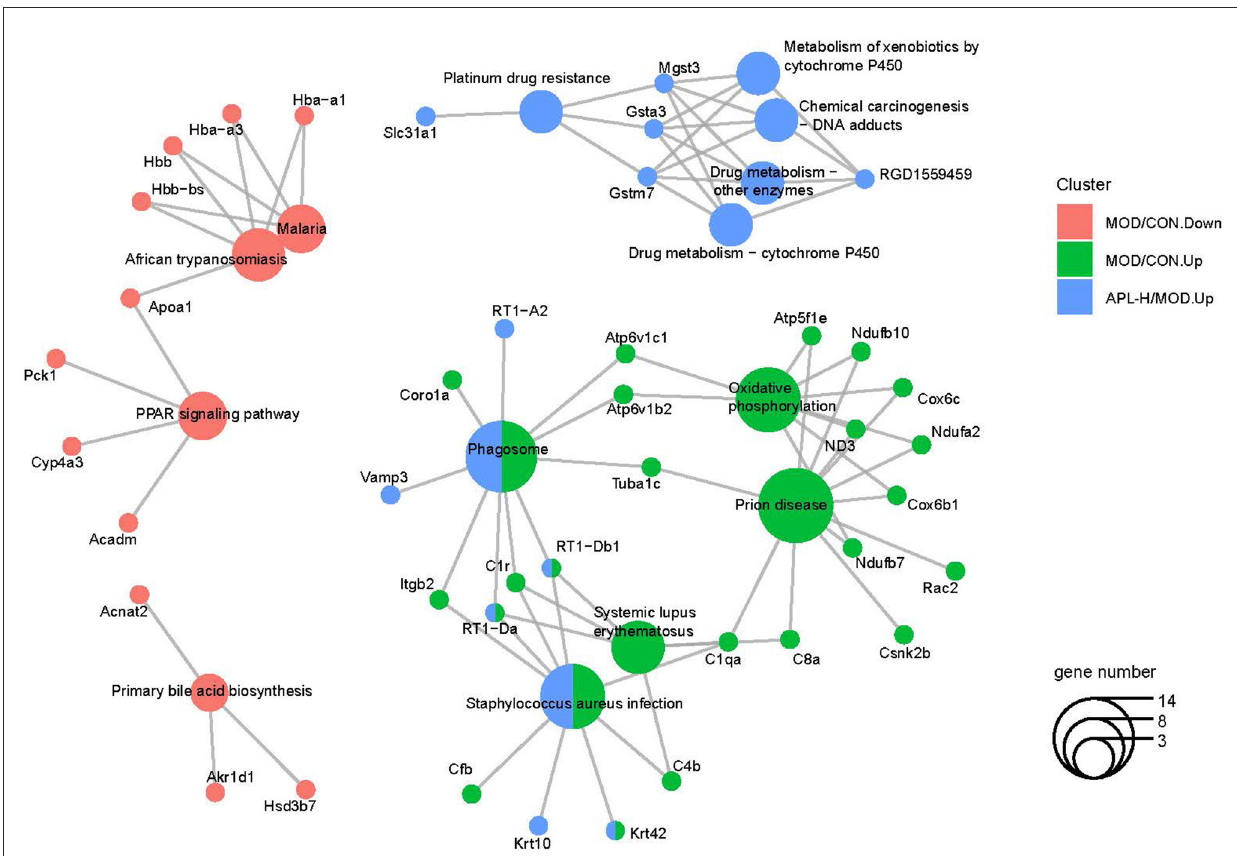
FIGURE10 Functionally grouped networks with pathways and genes derived from the Cytoscape database.